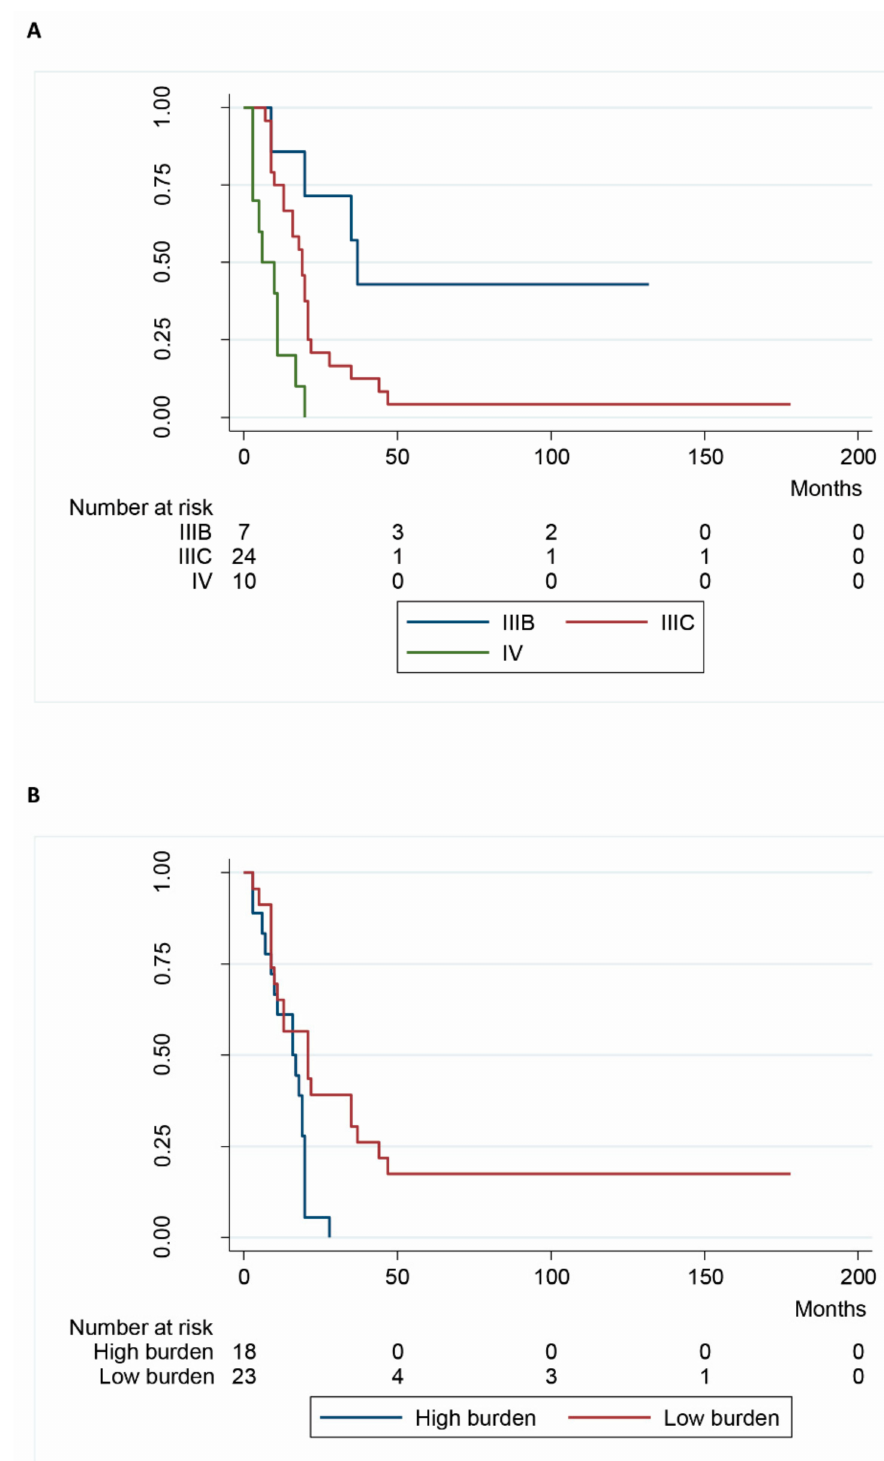
Figure 2. Kaplan-Meyer survival. ( A ) Stratified by Stage; ( B ) stratified by